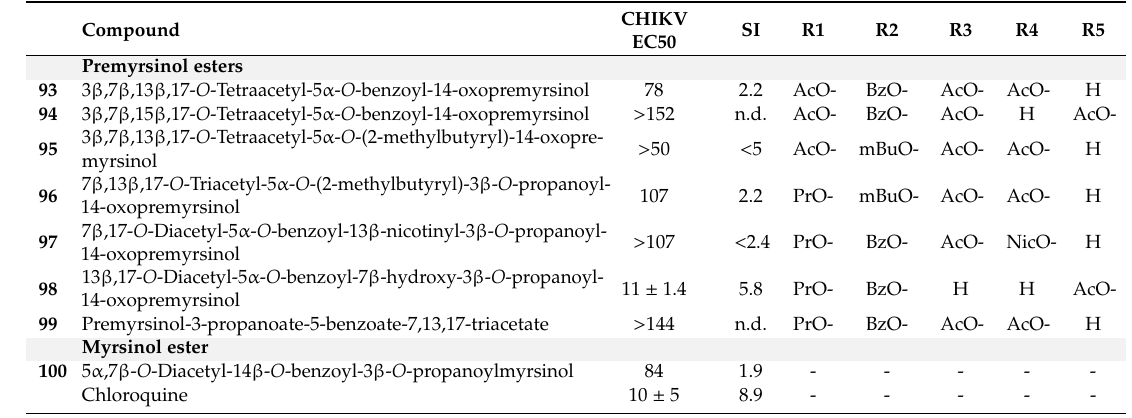
Figure 5. Structures of premysinanes 93 – 99 and myrsinane 100 . Table 4. Anti-CHIKV activities of premysinanes 93 – 99 and myrsinane 100 .